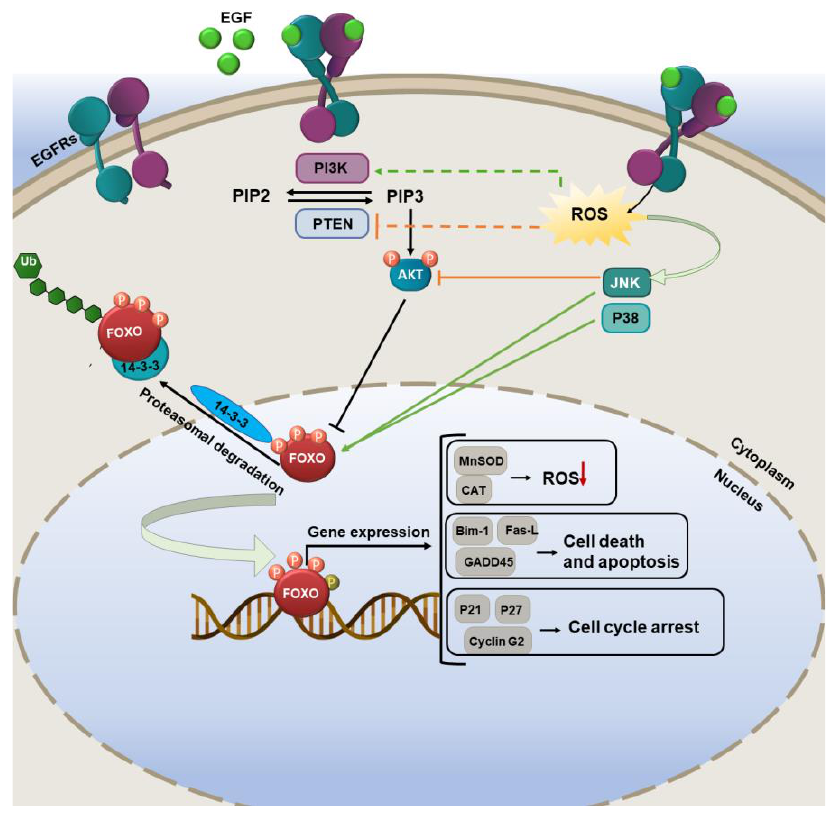
Figure 4. The FOXO pathway regulation by ROS. In oxidative conditions, phosphorylation of FOXO family members by various upstream effectors can trigger some antioxidant enzyme expression and reduce ROS levels in cells.